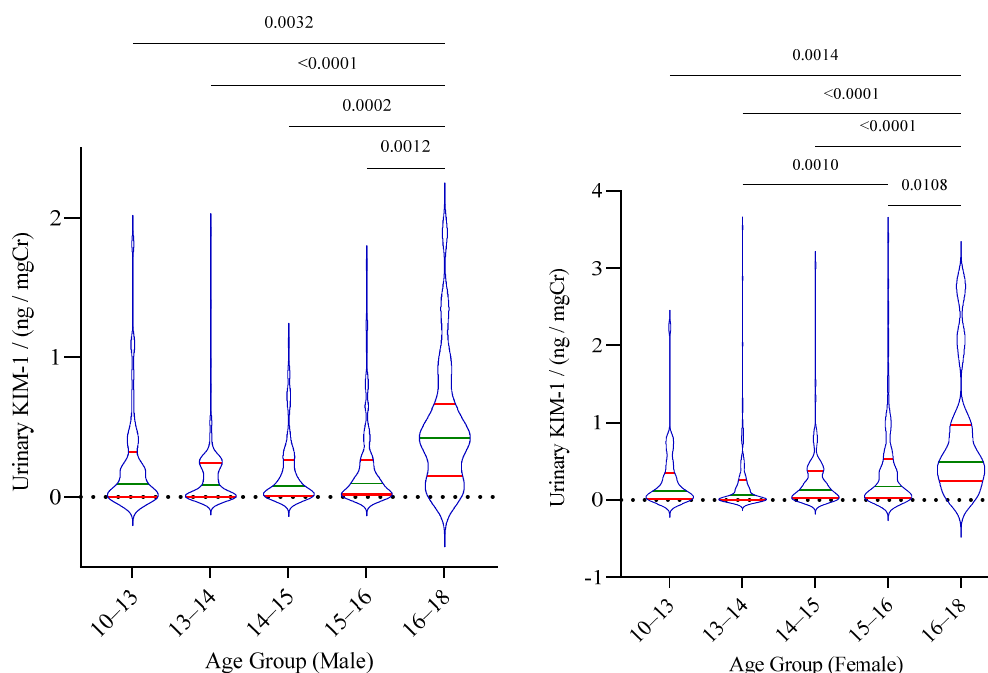
Figure 1. Distribution of urinary KIM–1 among the age groups of children. The median and inter-quartile range is shown for each group. Statistical significance is shown according to Kruskal–Wallis one-way analysis followed by Dunn’s multiple comparison test.